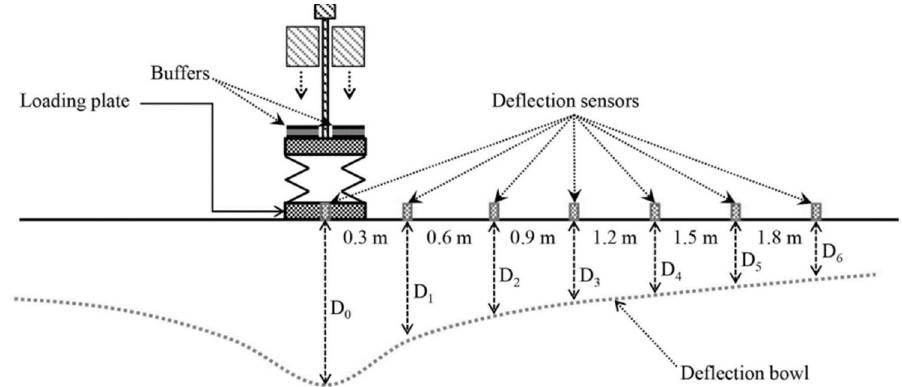
Figure 9. FWD deflection bowl with measuring geophone set-up.